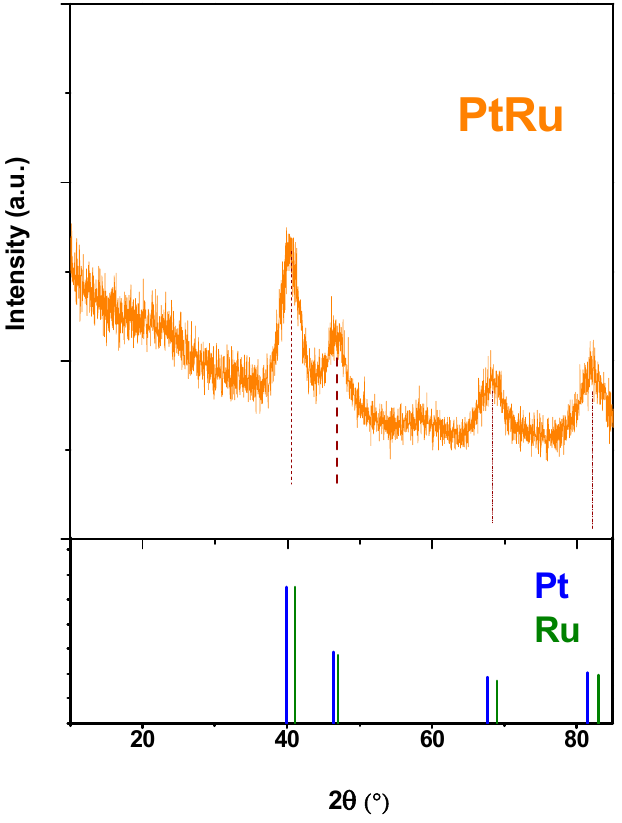
Figure 3. XRD spectrum of PtRu/MoS 2 nanoparticles.